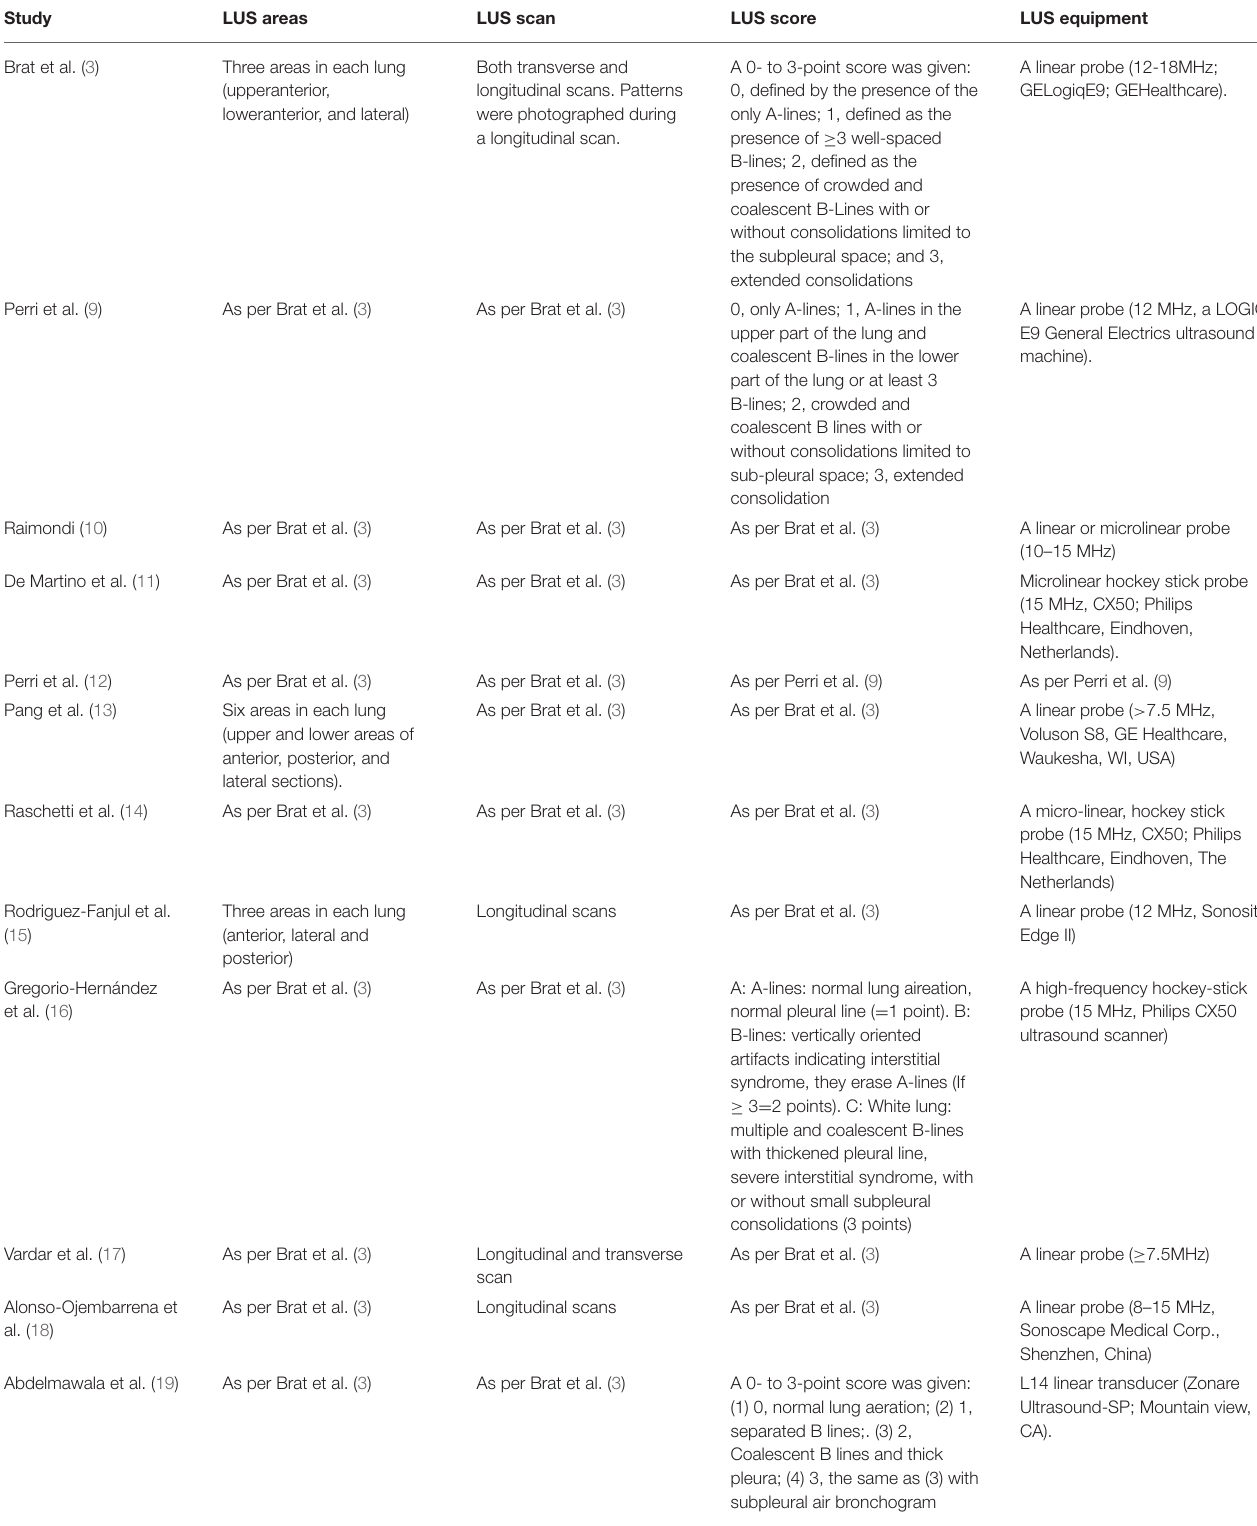
TABLE 1 | Summary of included studies of LUSs evaluating neonatal lung diseases.